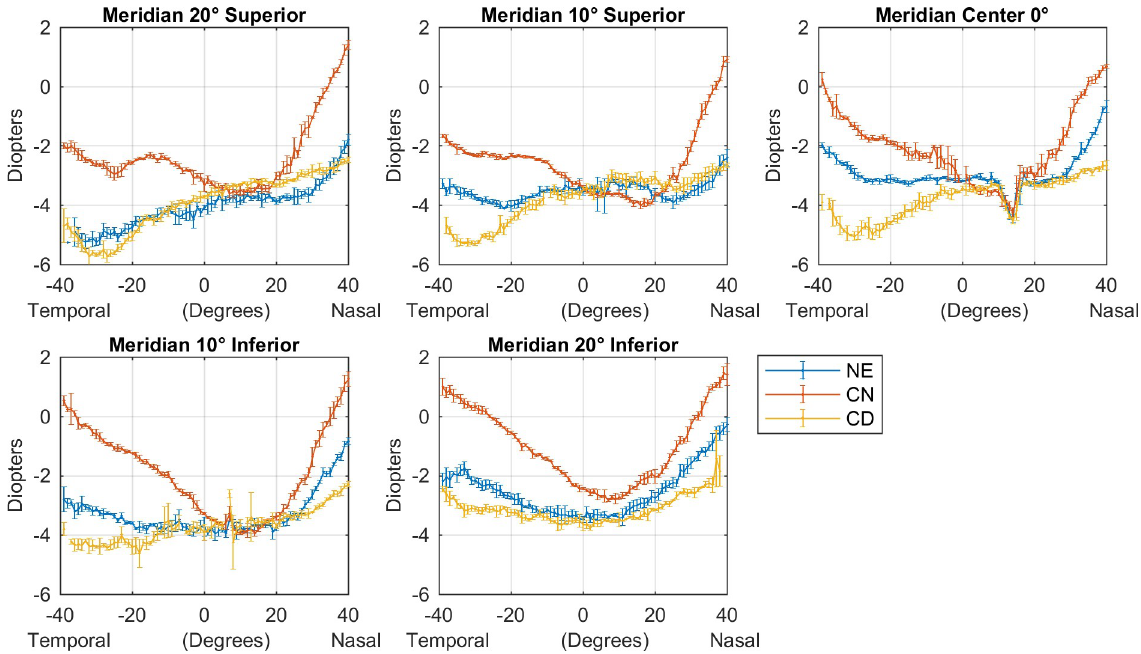
Fig 2. Error-bar plots of the peripheral refraction and “over-refraction” with the different contact lenses for one subject in each one of the five meridians in-use. In blue, peripheral refraction or naked eye; in red, over-refraction with near-centre design contact lens; in yellow, over-refraction with distance-centre